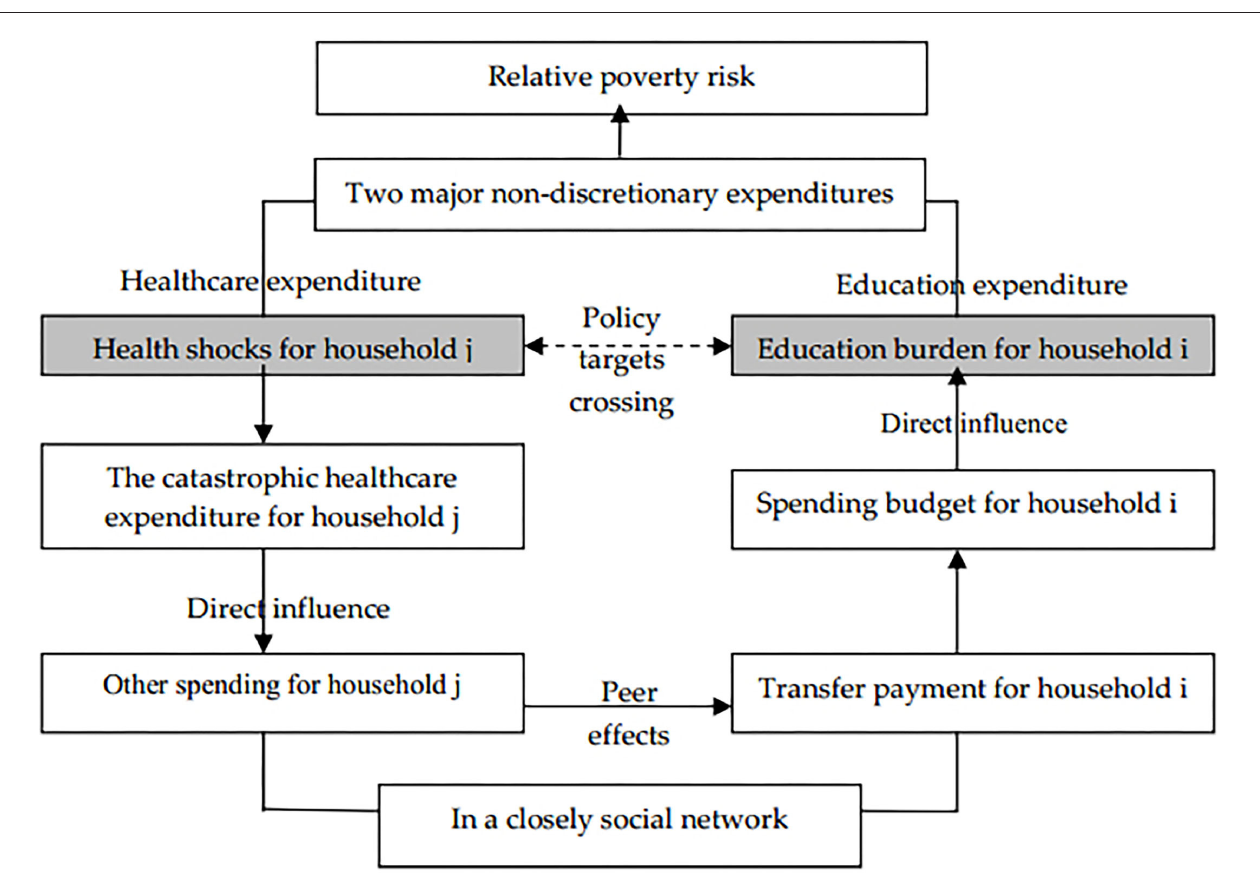
FIGURE 1 | The logic of spatial transmission process between health shocks and household education